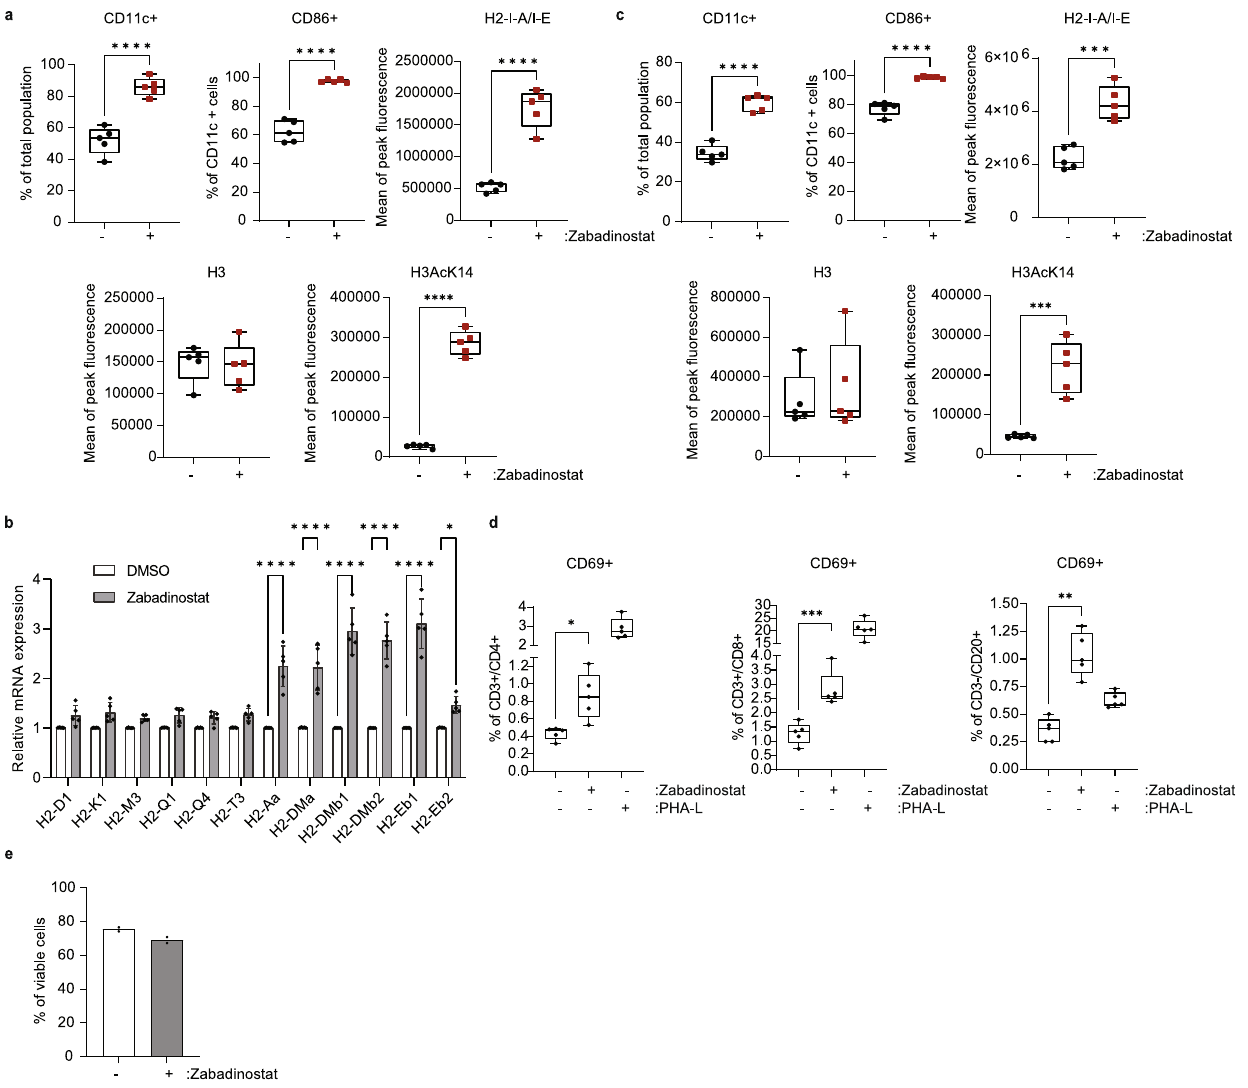
Fig. 3 Zabadinostat augments MHC expression in dendritic cells, and activates T and B lymphocytes. a Flow cytometry analysis of the extracellular MHC class II protein level in bone marrow (collected from C57BL/6)-derived dendritic cells (CD11c + /CD86 + ) treated with 1 µ M zabadinostat or DMSO control for 48h; n = 5, Student ’ s t test; the acetylation mark (H3AcK14) and total histone 3 level were detected by fl ow cytometry; n = 5, Student ’ s t test. b Quantitative reverse transcription PCR (qRT-PCR) of MHC class I and II genes was also performed; n = 5; results presented as mean values + / − SD; one-way ANOVA. c Flow cytometry analysis of the extracellular MHC class II protein level in bone marrow (collected from Balb/c)-derived dendritic cells (CD11c + /CD86 + ) treated with 1 µ M zabadinostat or DMSO control for 48 h, n = 5; the acetylation mark (H3AcK14) and total histone 3 level were detected by fl ow cytometry; n